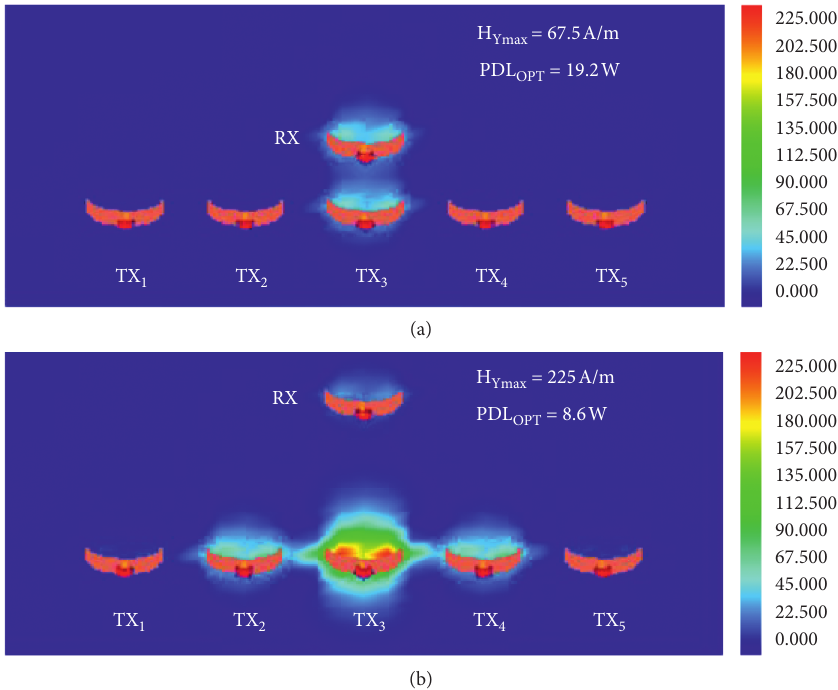
Figure 8: The distribution of magnetic fields of 5-TX WPT system for OV or OC Case. (a) D